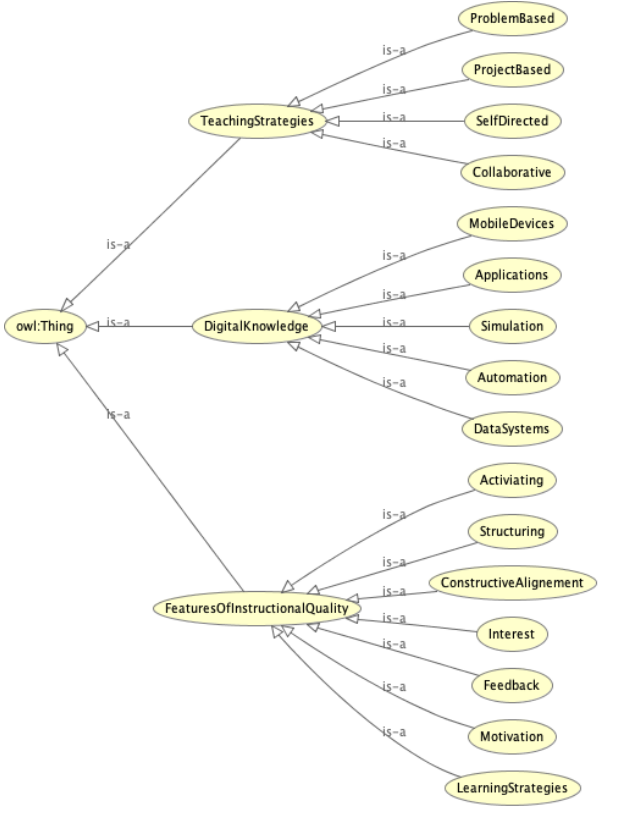
Figure 4. OWL ontology visualization from